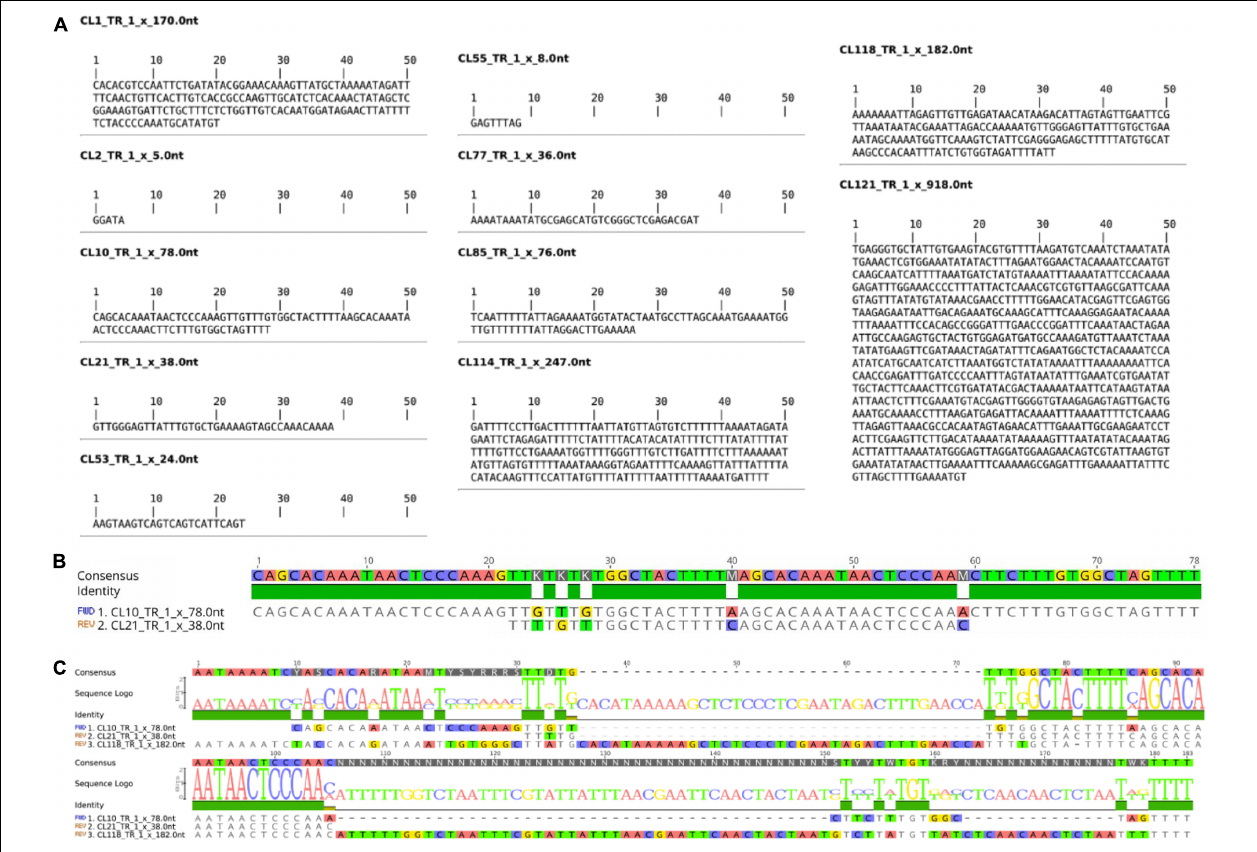
FIGURE 1 | Consensus Monomer and Characterization of WL satDNA Repeats. (A) Consensus monomer sequences of 11 satDNA clusters identified. (B) Characterization of the CL10 and CL21 satDNA repeat family. (C) Comparison of CL10 and CL21 with CL118, which also belongs to the same satDNA family but has evolved a longer repeat